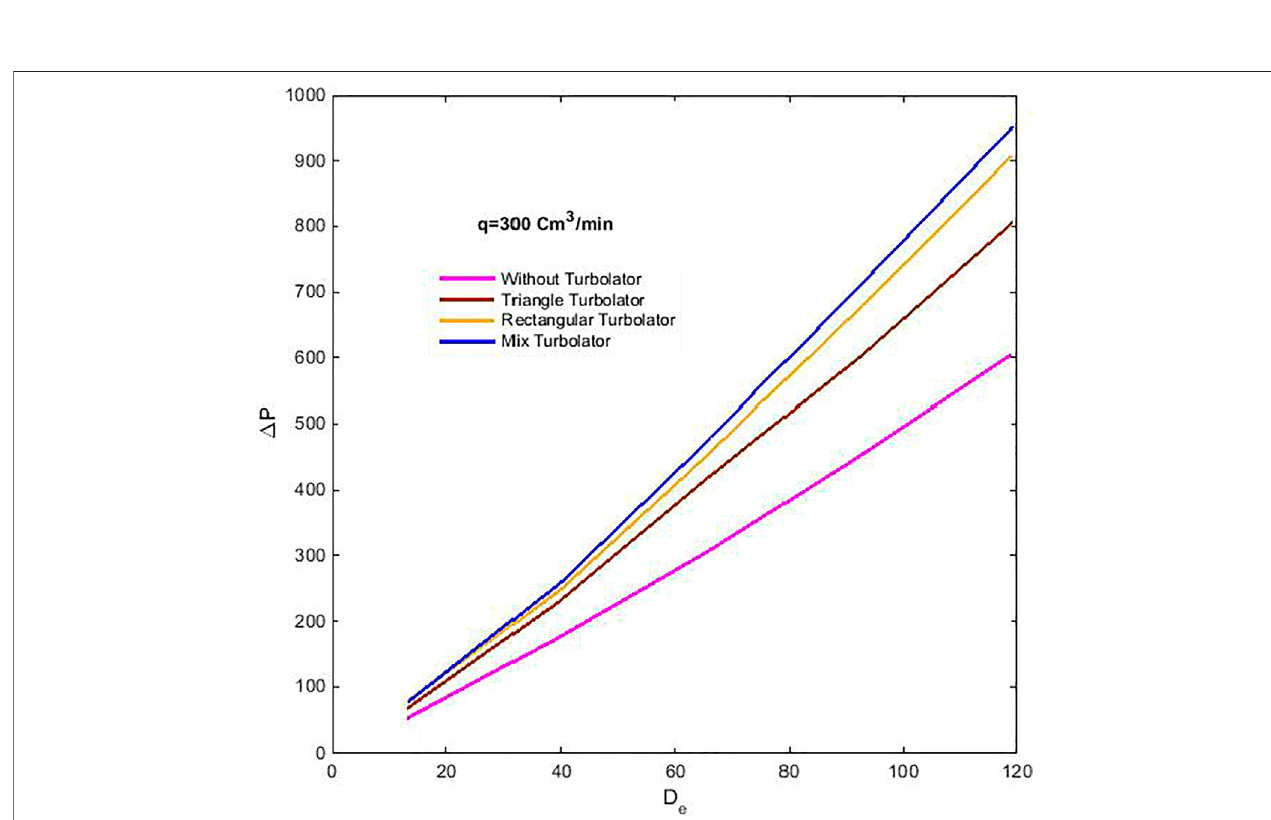
Frontiers in Energy Research |